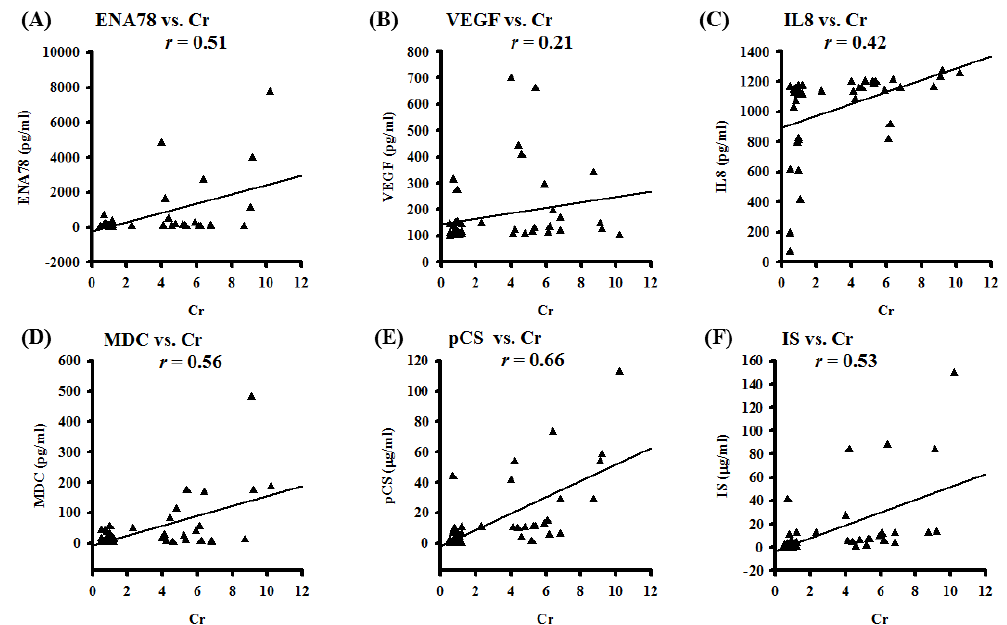
Figure 1. Pleural effusion concentrations of uremic toxins and selected chemotactic cytokines correlate with renal function tests in patients with respiratory distress. ( A ) The correlation coefficient r between ENA-78 and serum Cr is 0.51; ( B ) The correlation coefficient r between VEGF and serum Cr is 0.21; ( C ) The correlation coefficient r between IL8 and serum Cr is 0.42; ( D ) The correlation coefficient r between MDC and serum Cr is 0.56; ( E ) The correlation coefficient r between PCS and serum Cr is 0.66; ( F ) The correlation coefficient r between IS and serum Cr is 0.53.